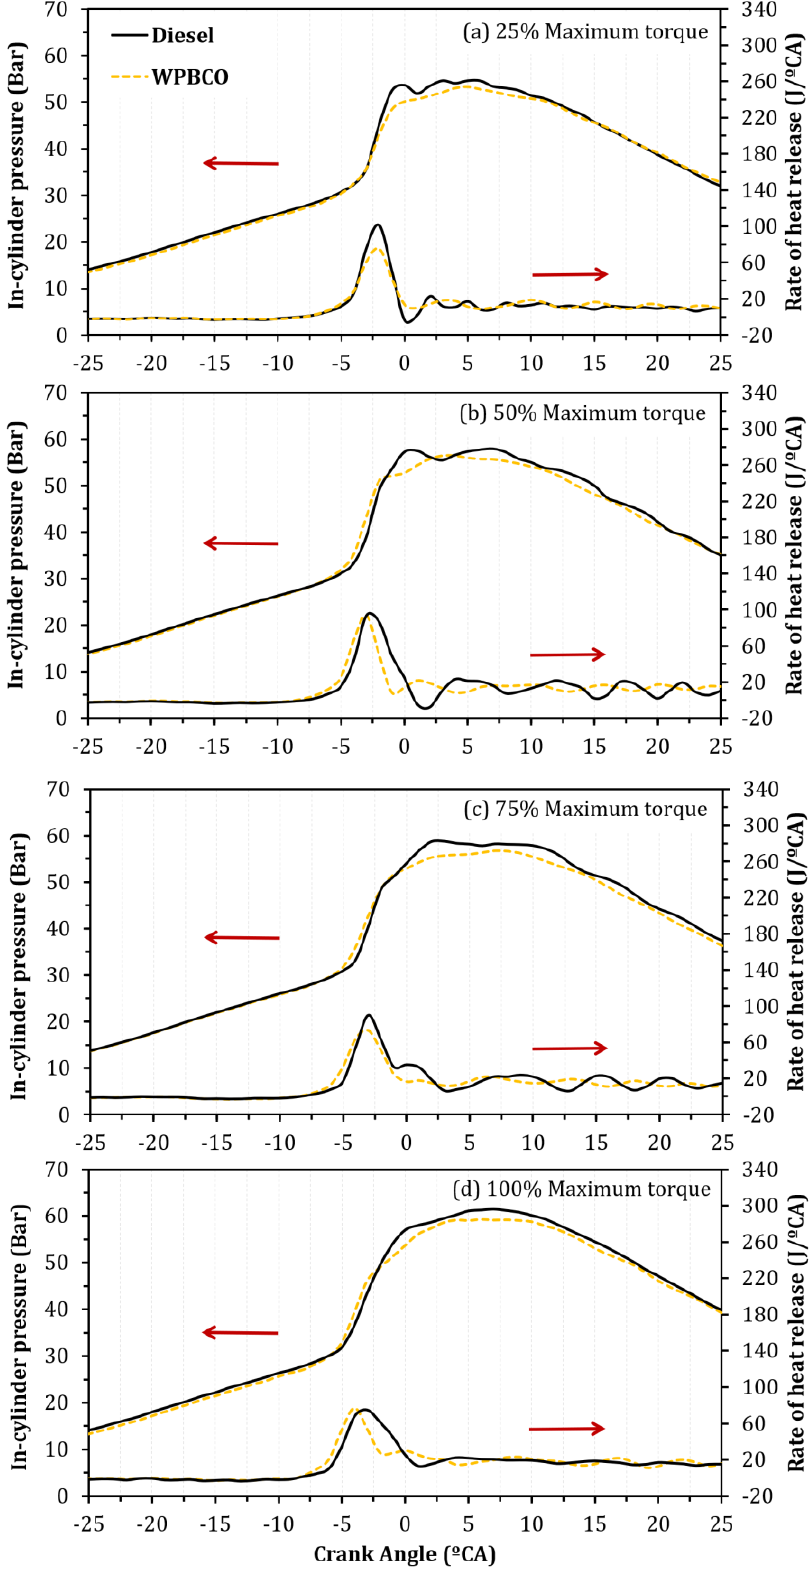
Figure 7. Combustion characteristics under different engine load for diesel fuel and WPBCO.